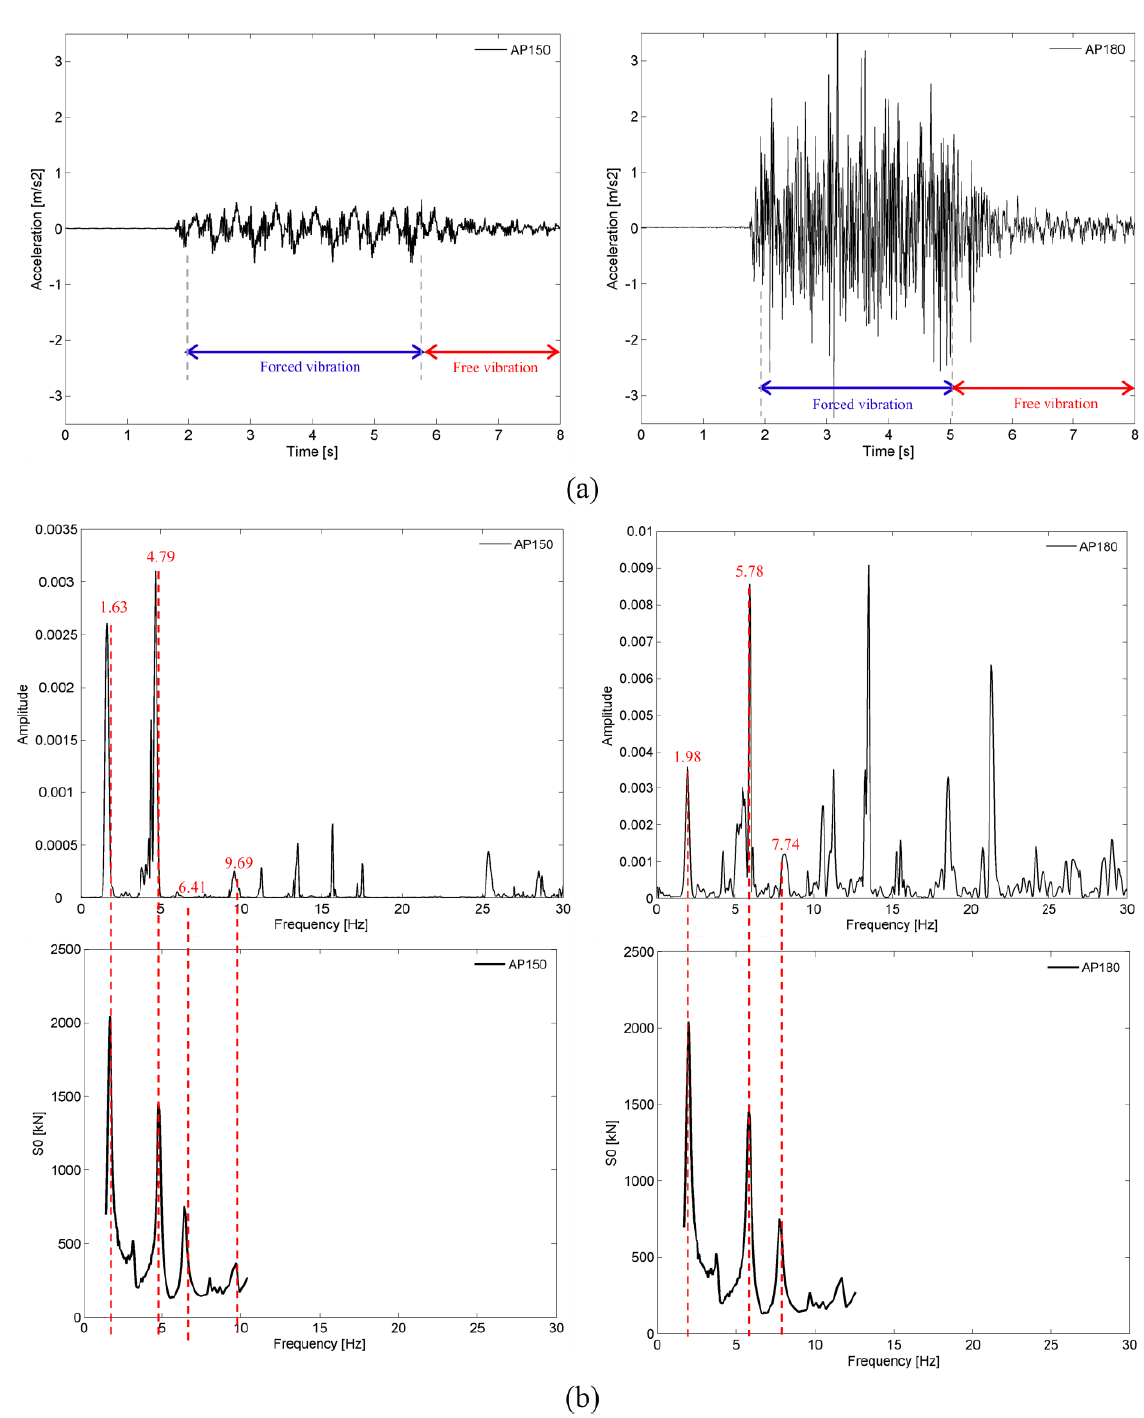
Figure 17. Vertical accelerations of the deck at point A1 for the passage of the Alfa Pendular train at speeds of 150 km/h (AP150) and 180 km/h (AP180): ( a ) time records; ( b ) auto-spectrum and dynamic signatures of the train.